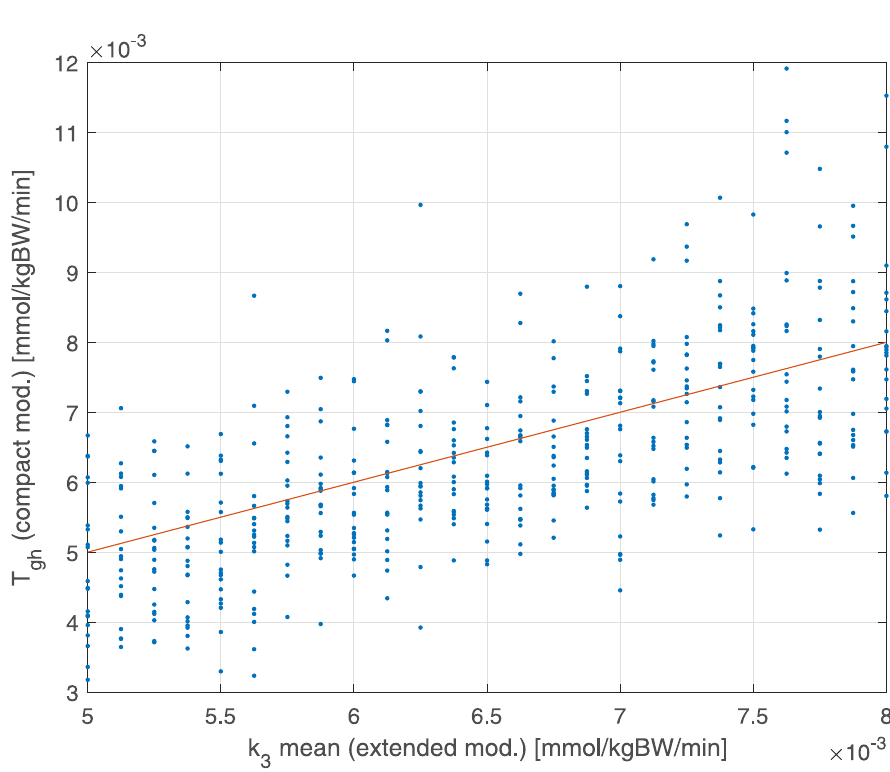
Fig 10. Dependence of estimated glucose net balance T gh (from the Compact Model comprehensive of the glycosuria term) from the generating � k correlation and its associated P-value: r = 0.68 ( P <